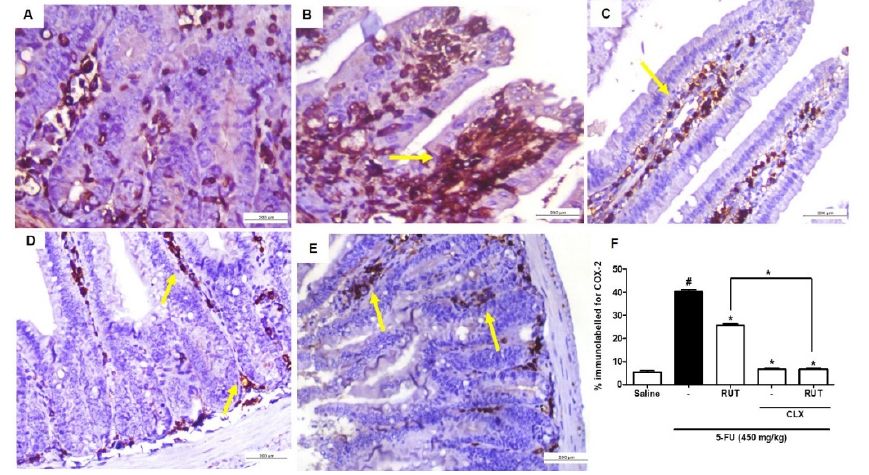
Figure 12. Immunohistochemical analysis of COX-2 expression. Saline ( A ); 5-FU ( B ); RUT-200 ( C ); CLX ( D ); RUT and CLX ( E ). % immunolabelled for COX-2 ( F ). Values are expressed as mean ± SEM. For statistical analysis, one-way ANOVA was used, followed by Tukey’s test. # p < 0.05 vs. saline group, * p < 0.05 vs. group 5-FU.